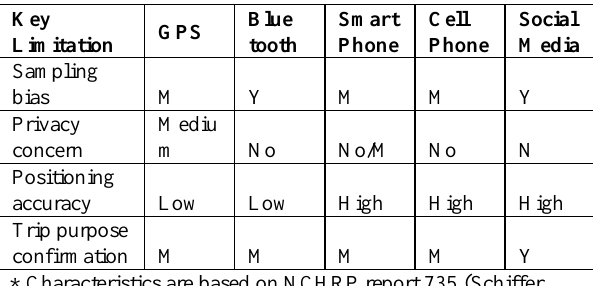
Table 1. Comparison among new and emerging travel